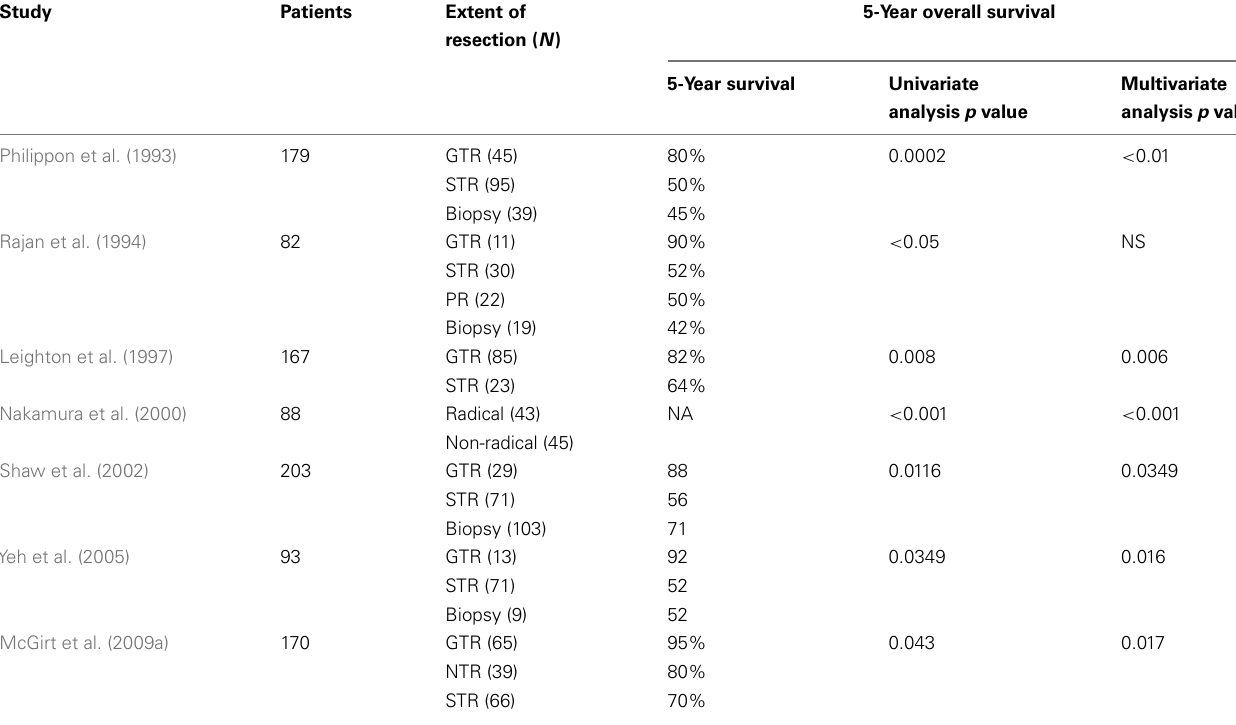
Table 5 | Positive low grade non-volumetric studies.